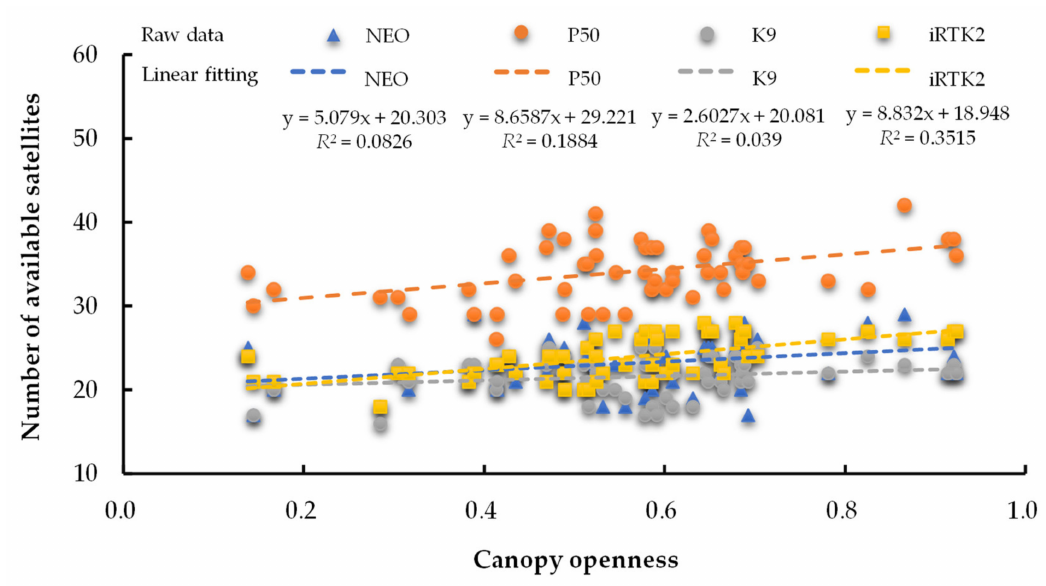
Figure 6. The number of available satellites with different canopy